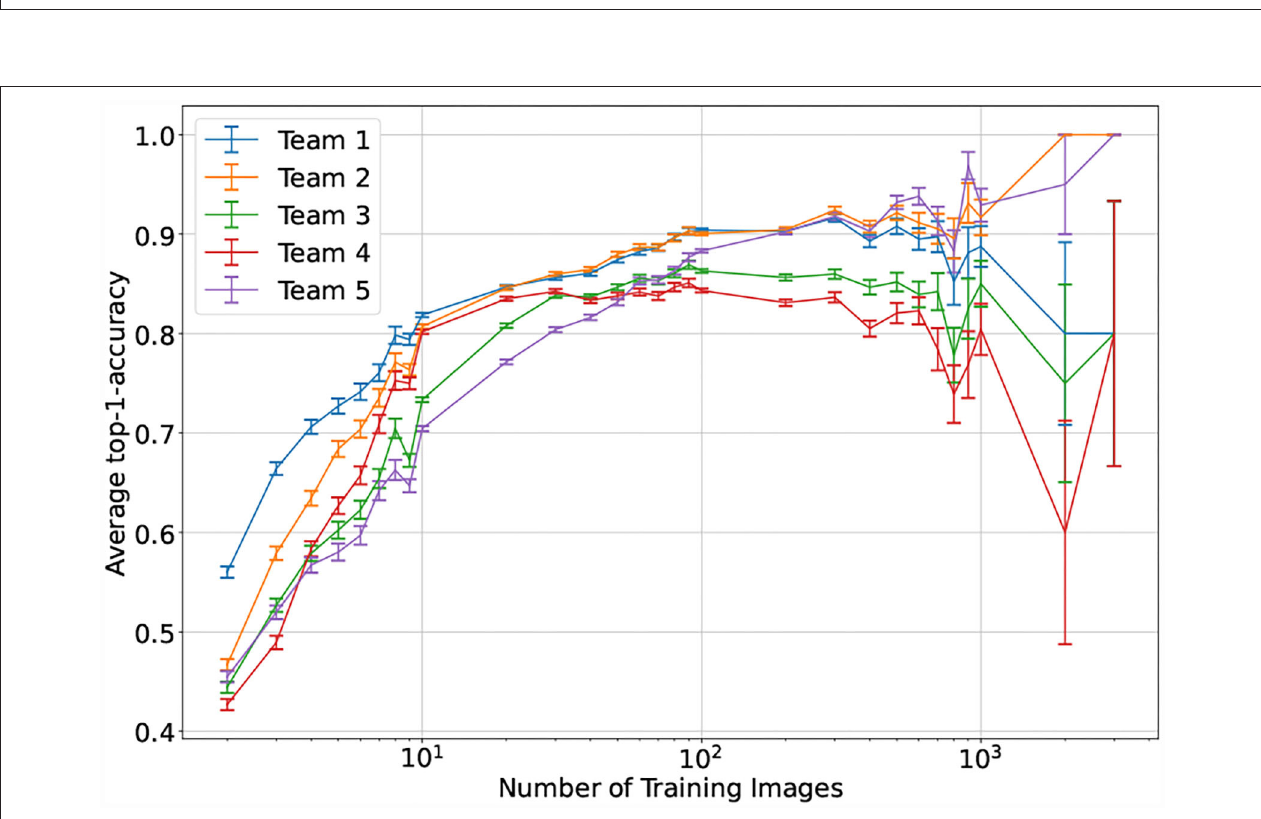
FIGURE 10 | Mean performance of the top–five models by number of training images. Taxa are aggregated based on their corresponding number of training images. The test time performance is then visualized as the mean of the top-1-accuracy for all taxa in a specific bin, the error bars correspond to the average standard error for each